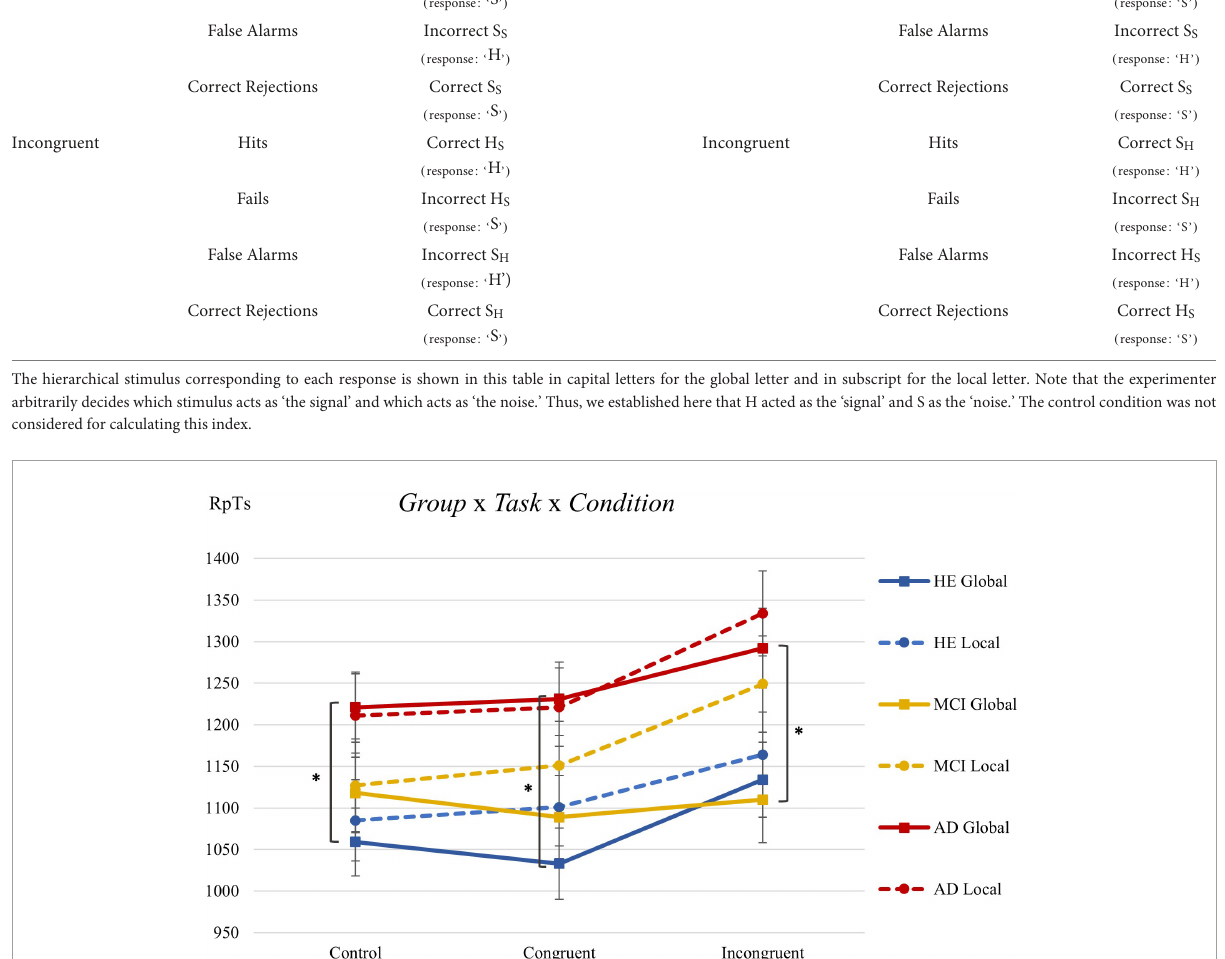
F (1,164) = 47.6, p < 0.001, η p 2 = 0.22 were found to